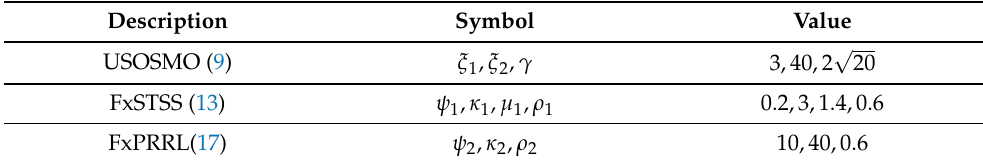
Table 2. Parameters of the proposed